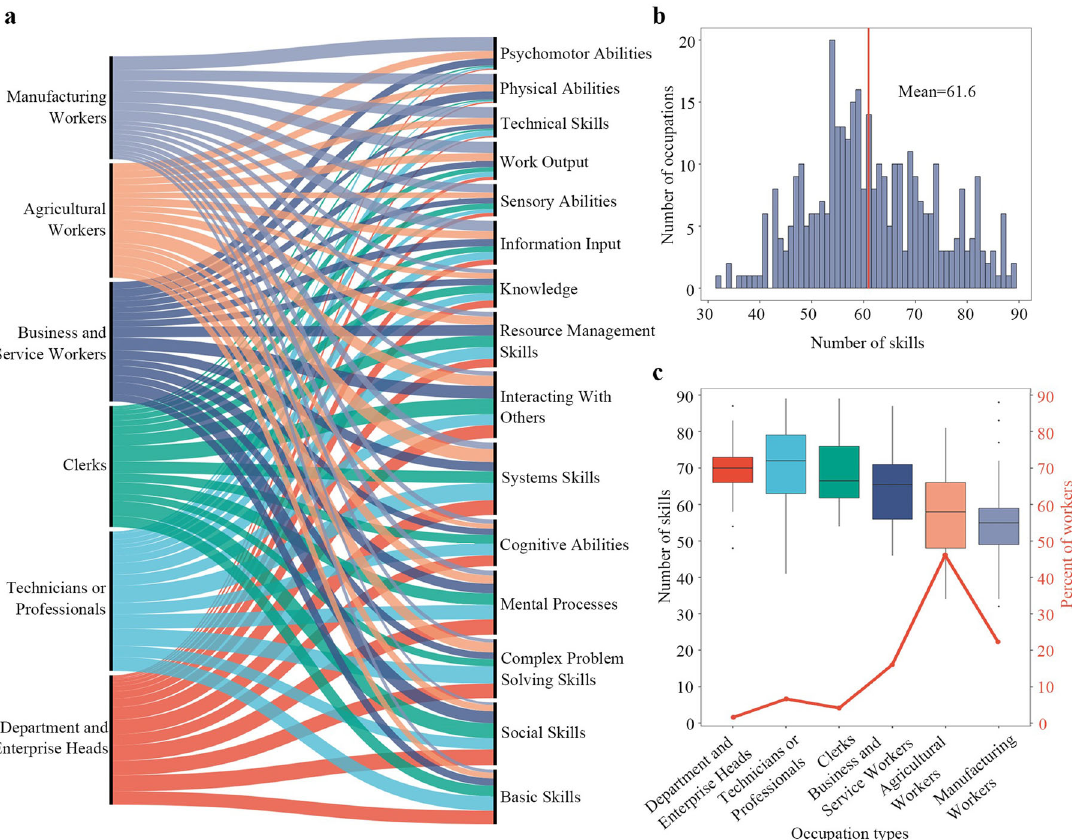
Fig. 3 Skill distributions over Chinese occupations. a The Alluvial Diagram indicates the degree to which the occupational groups depend on different skill sets. We aggregate the skill taxonomy into the 6 major occupational groups, and 15 skill sets de fi ned by the O*NET. The thickness of the line is proportional to the aggregated values of skill importance. b The frequency distribution shows skill distributions across all 353 Chinese occupations. The vertical red line describes the average numbers of skills that are required by Chinese workers. c The box-plot shows the numbers of skills that are important to the six major occupation groups; the red line shows the corresponding employment